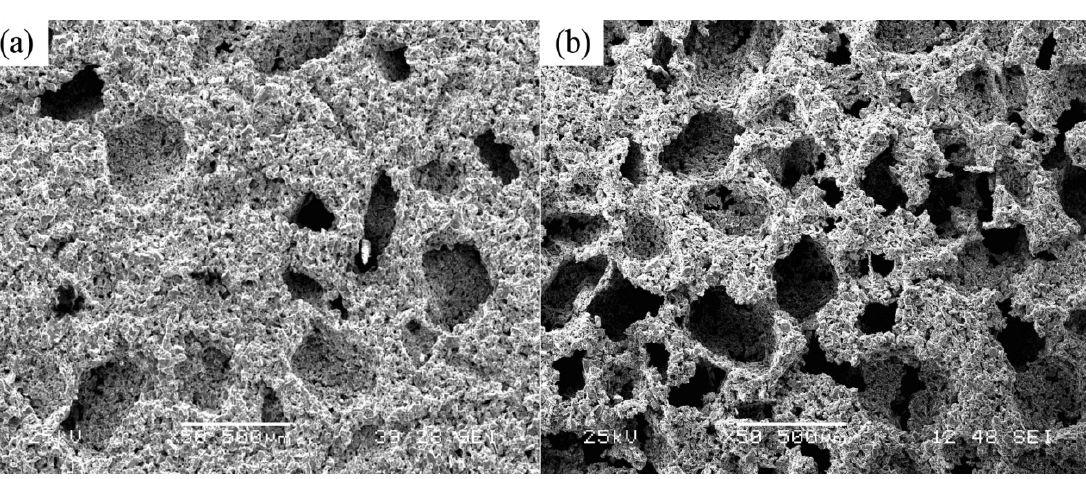
Figure 25. SEM microstructures of porous titanium by using MIM method with sodium chloride, sintered at 1150 °C for 2 h under a vacuum of 1.33 × 10 − 3 Pa: ( a ) 42.4%; ( b ) 71.6% [285]. Reprinted with permission from [285].Copyright 2009